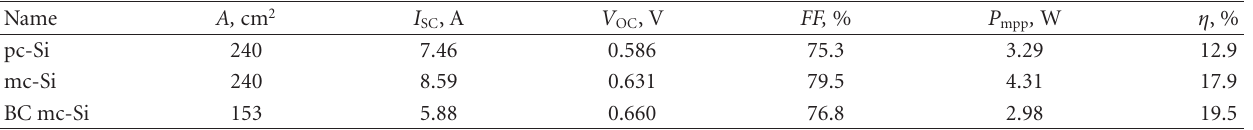
Table 1: Basic parameters of solar cells under investigation under STC.